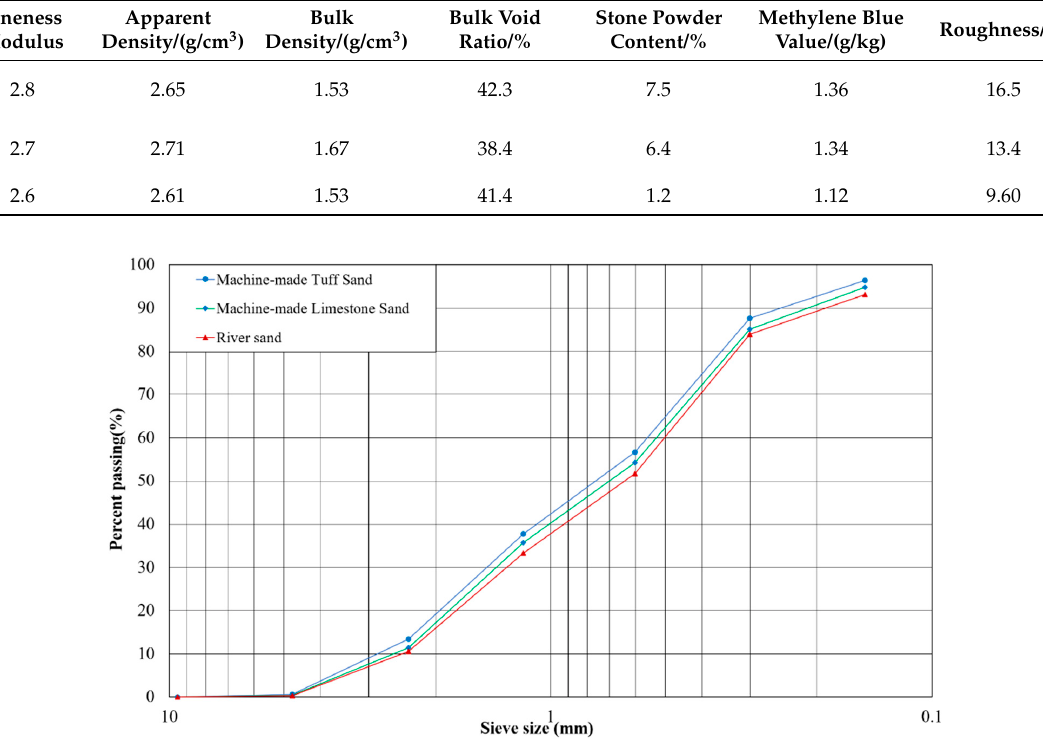
Table 1. Fine aggregate index properties.